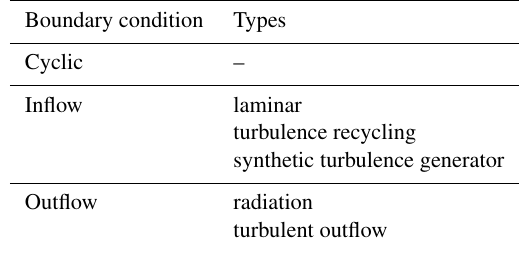
Table 9. List of lateral boundary conditions available in PALM. Boundary condition Types Cyclic –